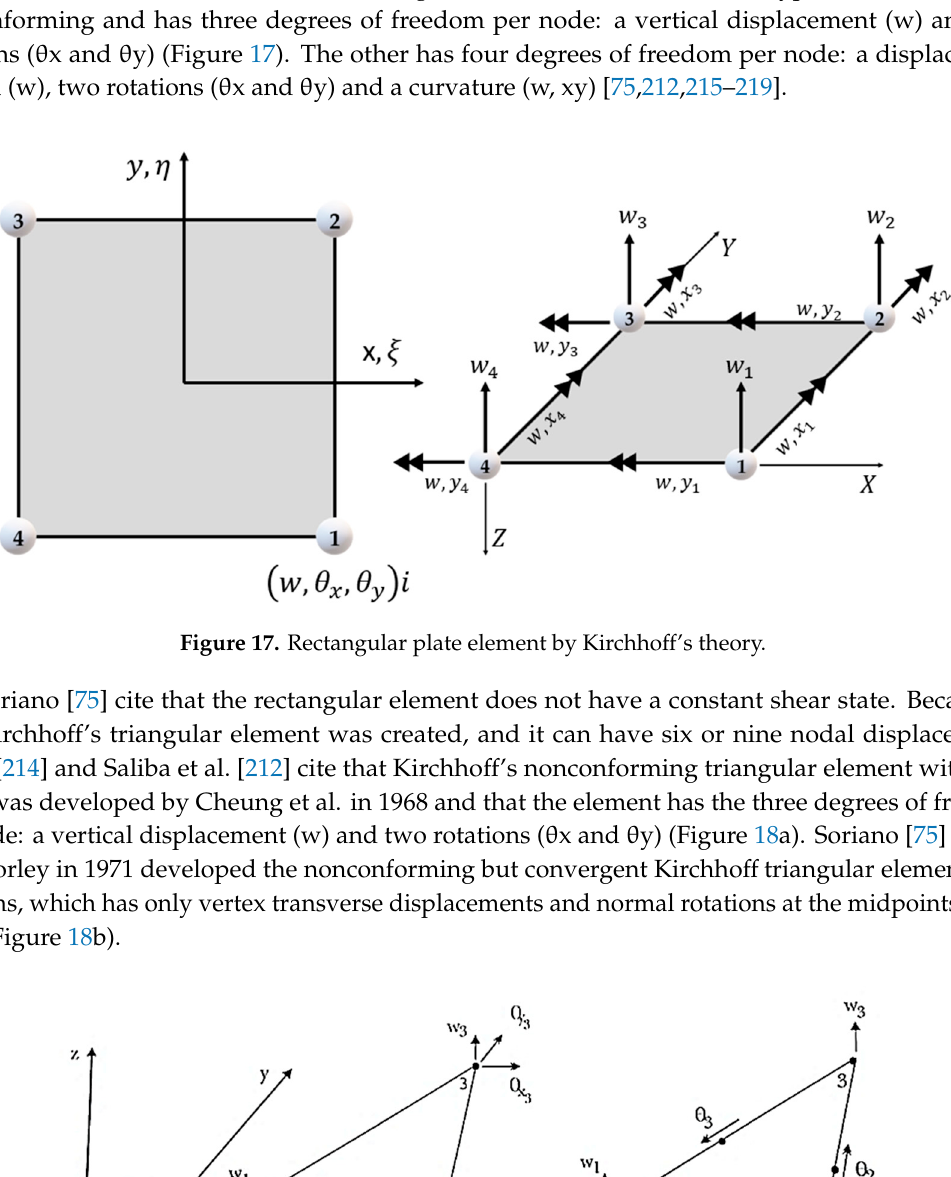
Figure 19. Compliant thin-plate elements. Reproduced with permission [75] . 5.1.2. Elements of Mindlin Theory Mindlin or Reissner–Mindlin theory for plates is equivalent to Timoshenko theory for beams, in which the main hypothesis is that the cross section of the beam remains flat, but not necessarily perpendicular to the tangent of the elastic line when deformed [21,203,207,209,210,213]. Mindlin theory is hierarchically superior to the Kirchhoff because it presents a three-dimensional solution and can be applied for both thin plates and spines [75,206–208]. Mindlin theory is a shear-deformable plate theory [203]. According to Soriano [75], Altenbach and Eremeyev [203], Saliba et al. [212] and Vaz [201], the kinematic hypotheses of Mindlin's theory are:  Any point P (x, y) on the average surface of the plate moves only in the z direction—that is, it has only vertical displacement w (x, y);  The normal stress in the z direction ( σ z) is negligible;  The vertical longitudinal strain is zero at any point on the plate—i.e., ε z = 0;